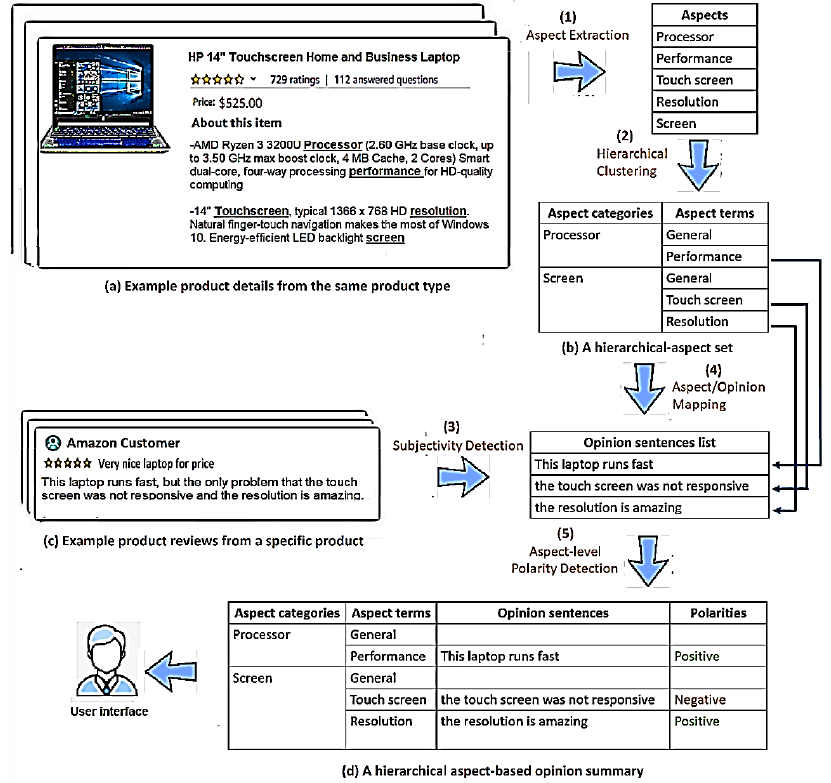
Figure 1. The steps of the proposed approach: SEOpinion.